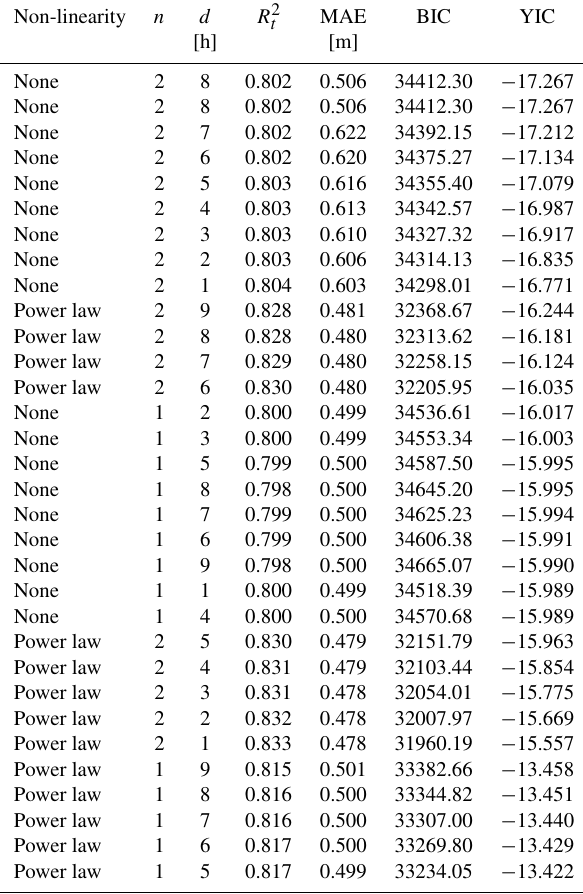
Table 3. Summaries of the performance of a subset of models dur- ing the calibration period (1 April 2011–30 September